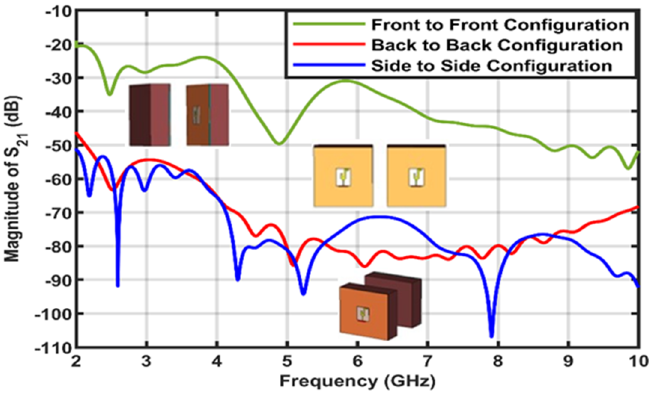
Figure 25. S 21 analysis for the on-body antenna using various configurations.